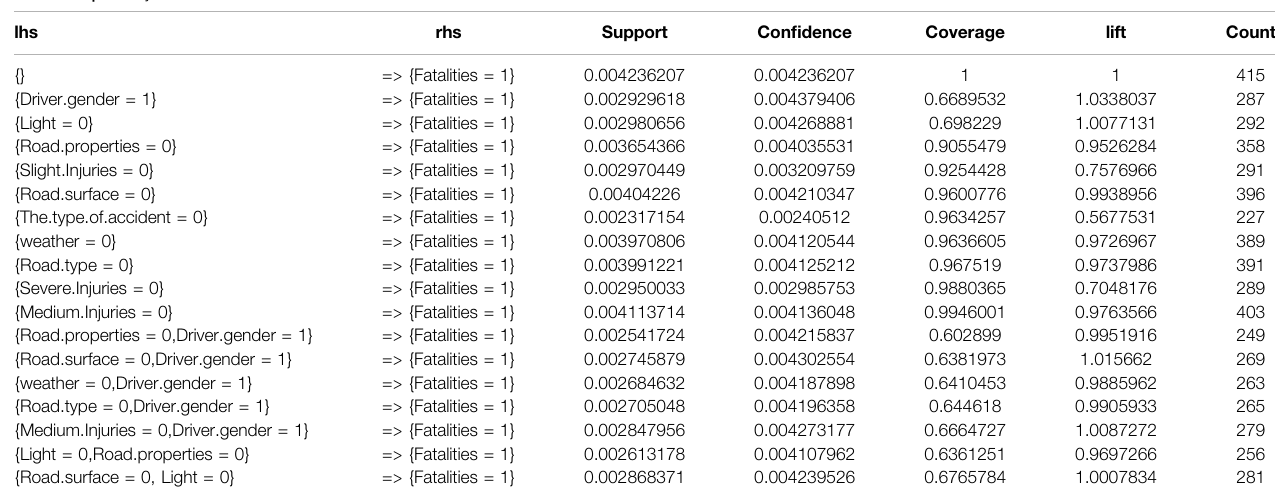
TABLE 7 | Fatality